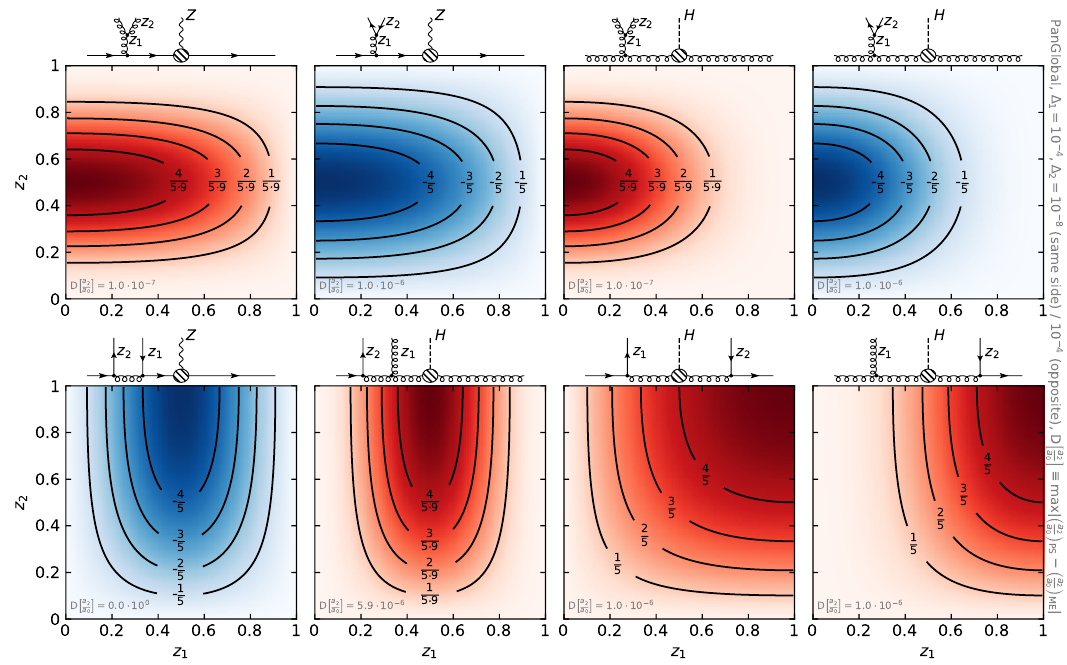
) for collinear splittings. The Feynman s as predicted by the shower. Black 2 /a 0 (cid:1) the analytic prediction for a 0 ME